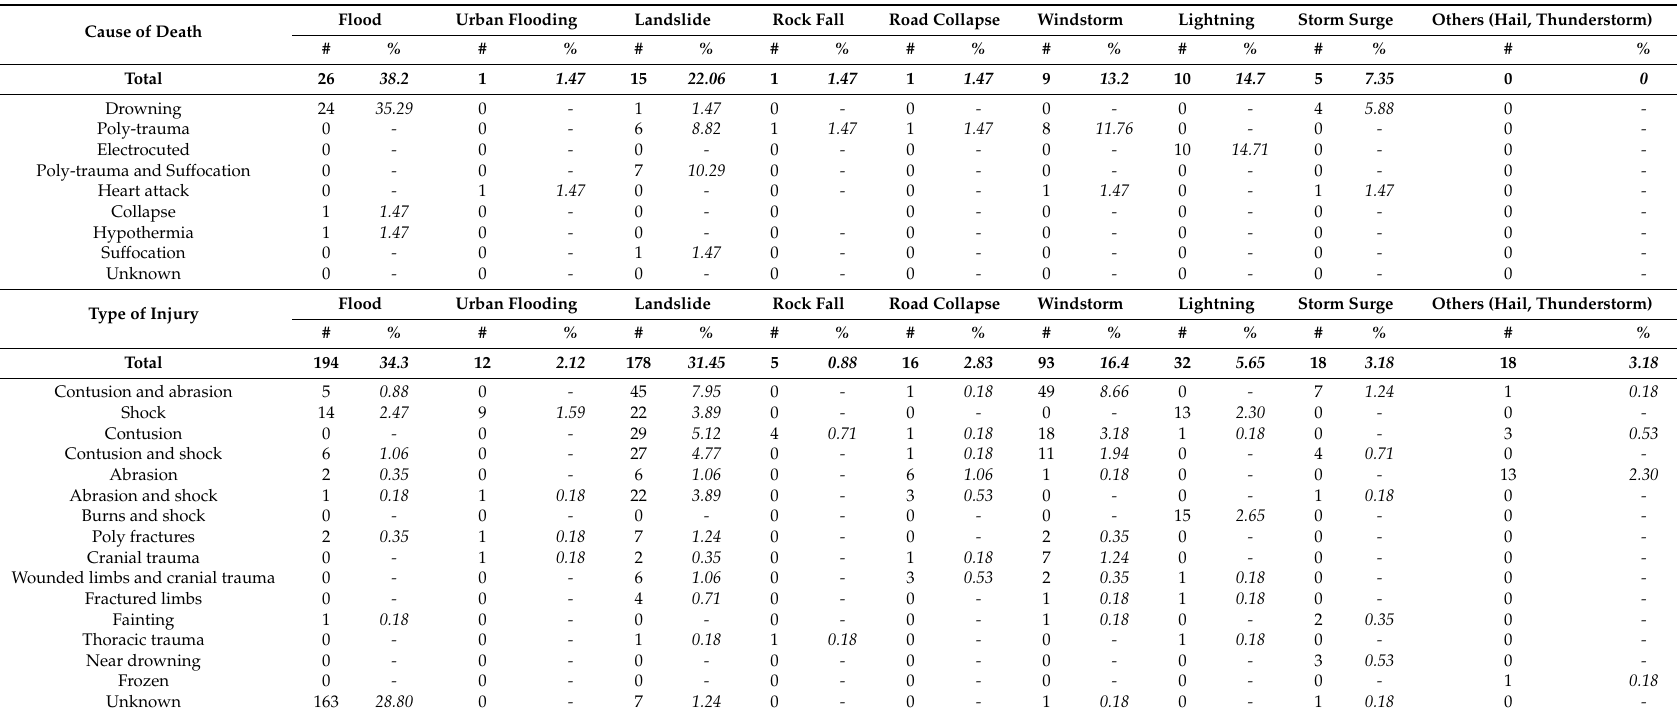
Table 8. Causes of death and types of injures according to type of